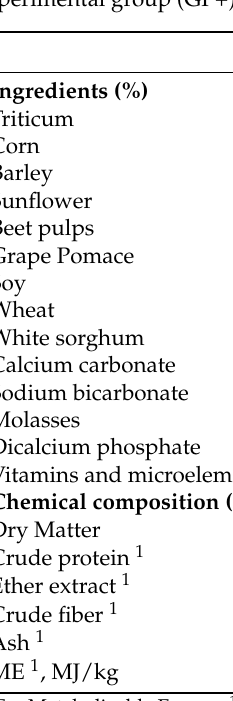
Table 1. Nutrient and chemical composition of the diet administered to the control group (Ctrl) and experimental group